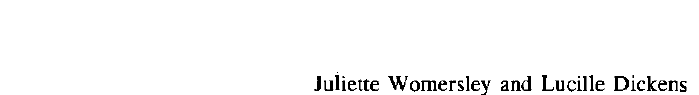
Table 2 Whole-slope index mV values for groups A, Β and C